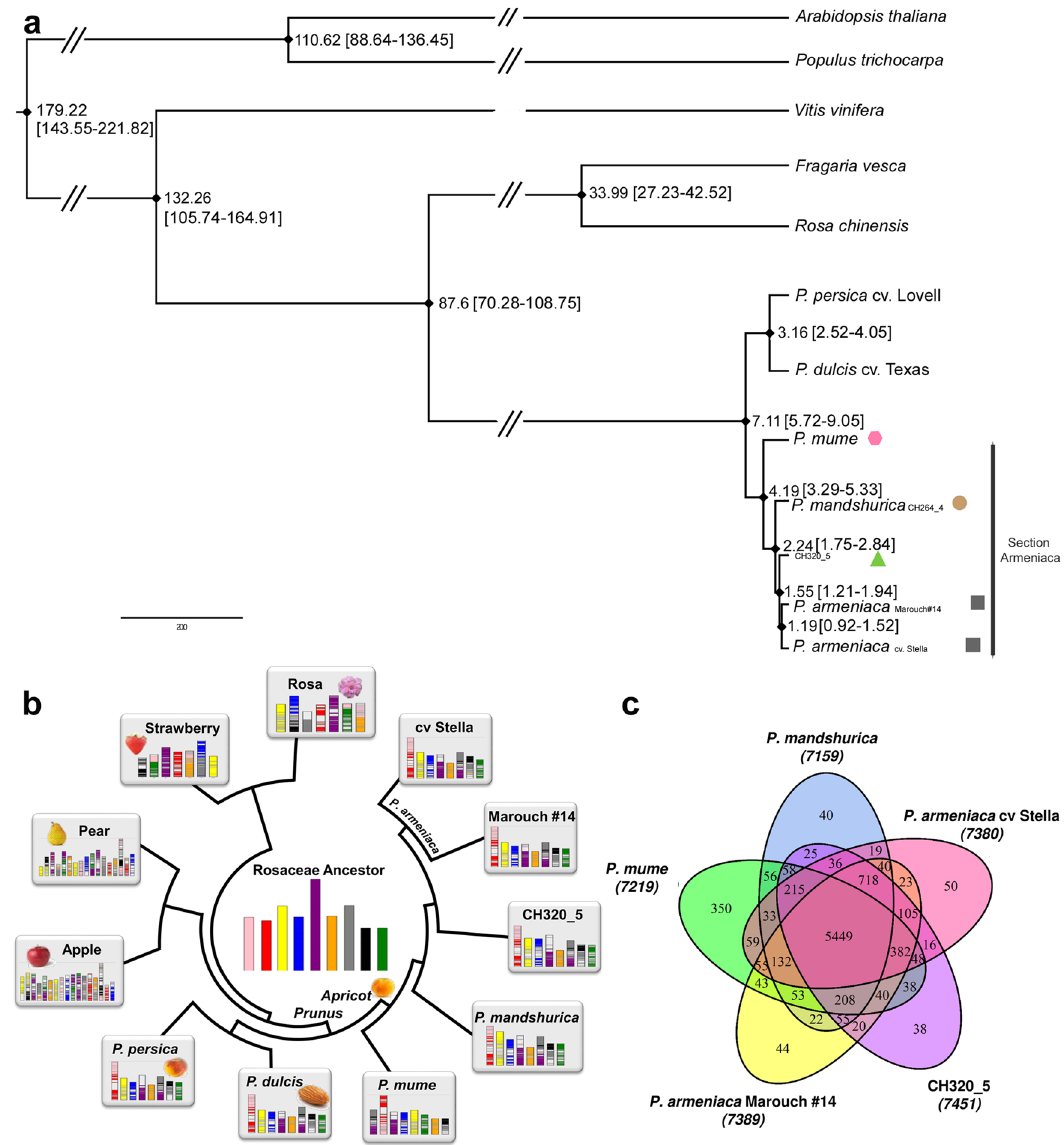
Fig. 2 Reconstruction of Armeniaca phylogeny and chromosome structural evolution. a Species tree. The phylogenetic tree was constructed on the basis of neutrally evolving sites from 298 shared single-copy orthologs. The values on the branch (in Mya) are the times of divergence estimated with BEAST and in brackets the con fi dence intervals. Pink circle: P. mume , beige circle: P. mandshurica ; green triangle: P. sibirica CH320_5, grey rectangles: European P. armeniaca cultivars. b Chromosome structural evolution within Rosaceae. The modern Rosaceae genomes are illustrated with different (arbitrary) colors re fl ecting the origin from the nine chromosomes (center) of the inferred ancestral Rosaceae karyotype (ARK). c Numbers of ancestral Rosaceae genes conserved in the fi ve modern apricot genomes shown in a Venn diagram, with arbitrary colors to better see the different groups. Source data are provided as a Source Data fi le and in Supplementary Data